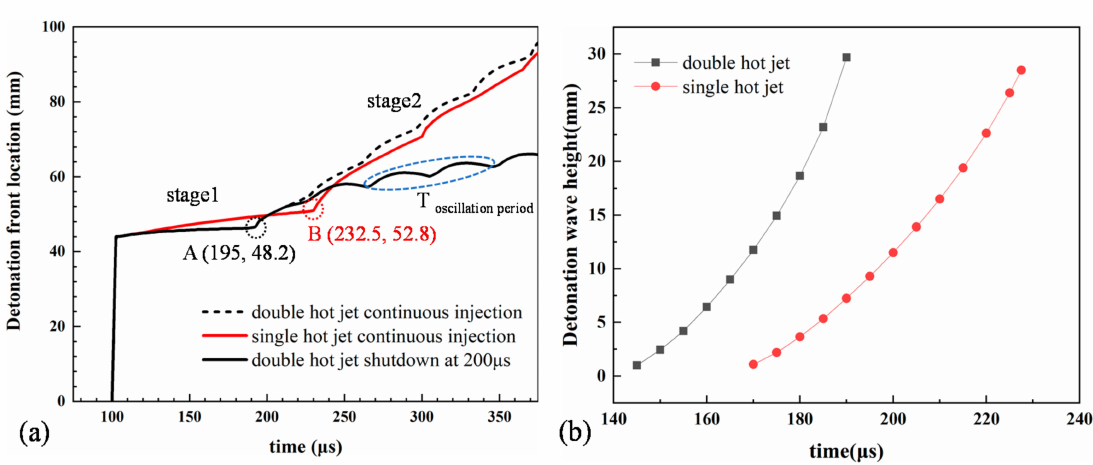
Figure 10. ( a ) Trajectory of detonation front along lower wall. ( b ) Detonation wave